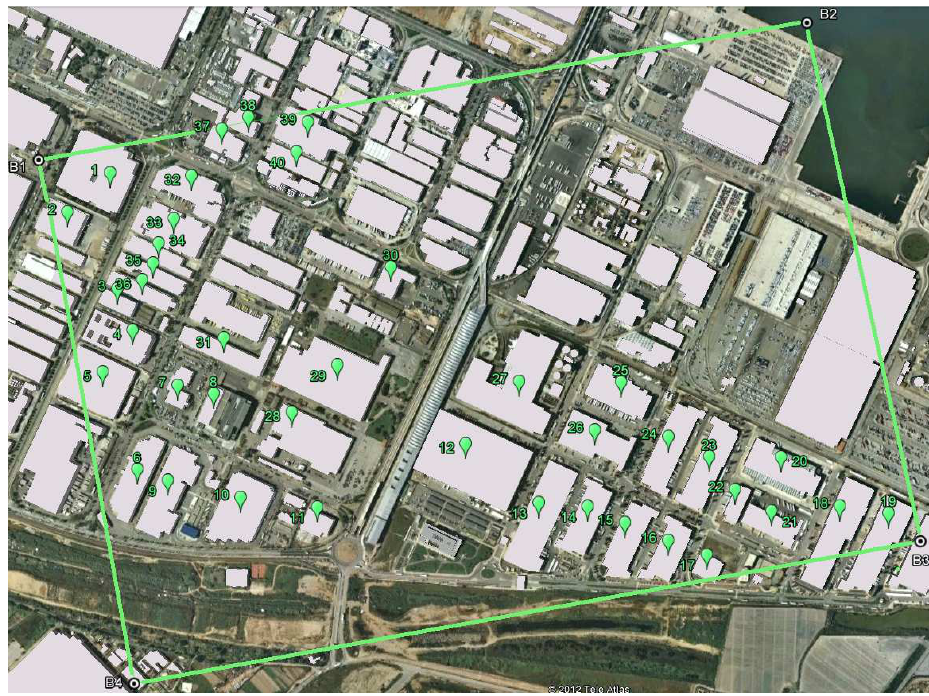
Figure 5. Selected buildings on Google Earth for PS